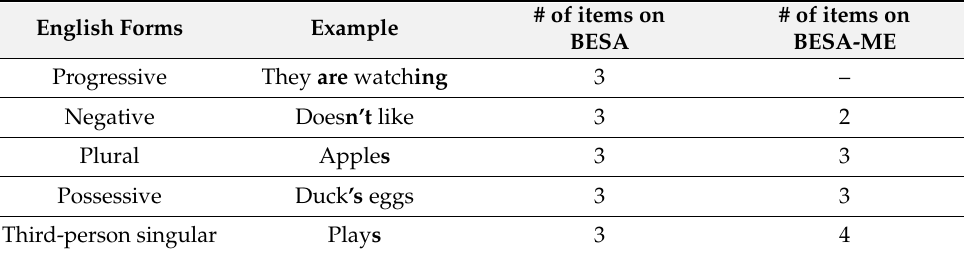
Table A2. Morphosyntactic cloze composites a , derived from Bilingual English Spanish Assessment b and Bilingual English Spanish Assessment—Middle Extension